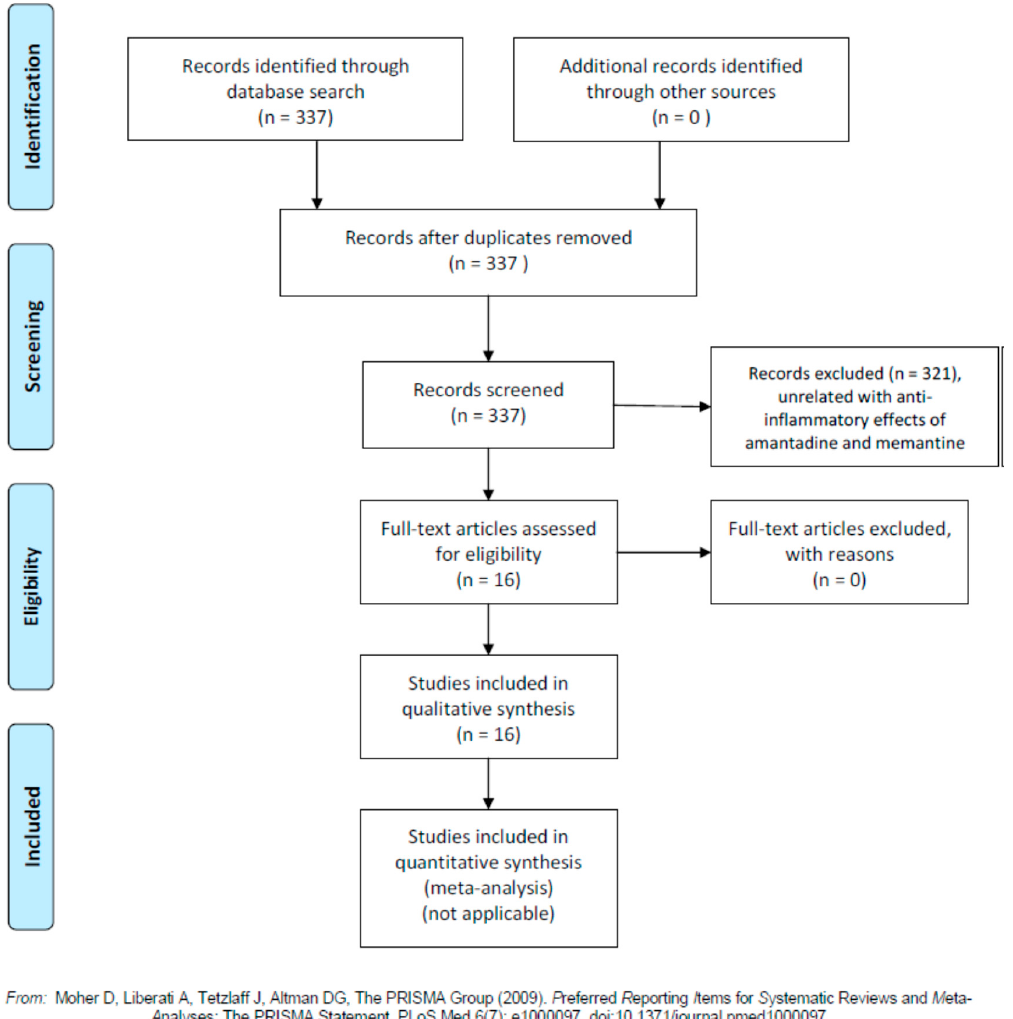
Figure 1. Flowchart of the studies on anti-inflammatory e ff ects of amantadine and memantine. For